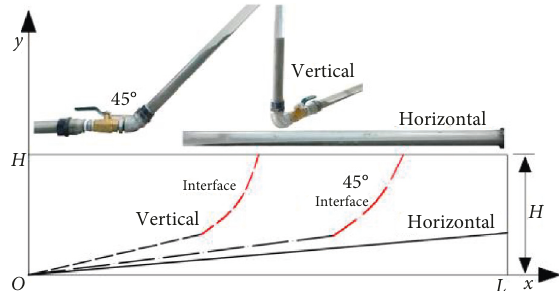
Figure 6: Interfaces of water and slurry stone body after water separation with different dip angles. L is the penetration distance, and H is the diameter of the glass tube (fracture